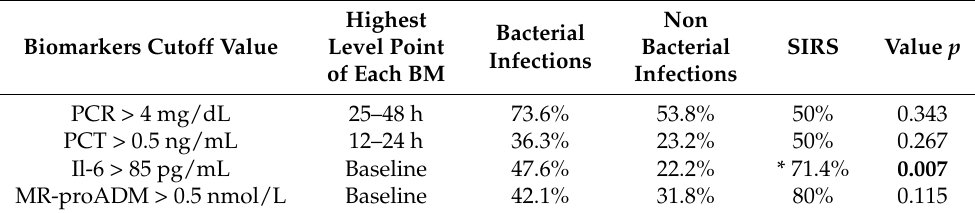
Table 5. Percentage of patients with biomarker levels above their respective cut-off values at the highest level point. Biomarkers Cutoff Value